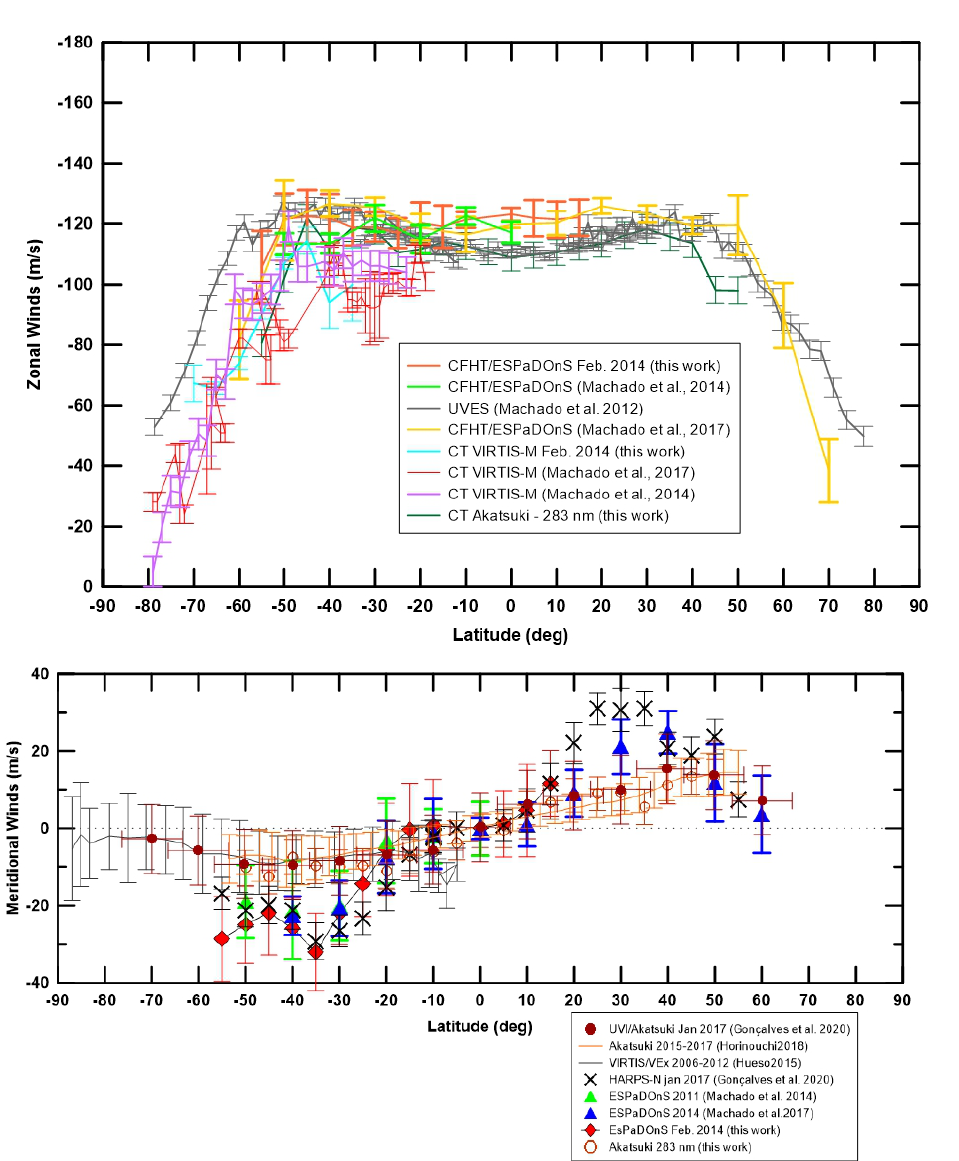
Figure 10. Comparison between wind results obtained in the context of the present work and other similar results from our group’s previous works. In the upper panel, we display several latitudinal zonal wind profiles obtained by our group at several coordinated observational projects. Space- based (cloud-tracked winds) observations were performed by VEx VIRTIS-M (380 nm), and our simultaneous (or almost simultaneous) day-side observations were made using the high-resolution spectrograph ESPaDOnS at the CFHT telescope (Doppler velocimetry). The comparison between the zonal wind profiles obtained from high-resolution spectra and Doppler velocimetry techniques and cloud-tracked zonal winds retrieved from Akatsuki/UVI instrument with its 283 nm filter, analysed in the framework of this project, is also presented here. (Lower panel) The same as for the upper panel, but in this case, we compare Doppler velocimetry (ground-based) meridional wind latitudinal profiles with the ones retrieved from cloud-tracked winds (space-based). The set of latitudinal meridional wind profiles shown here were retrieved in the scope of this work and compared with the results from our group’s previous projects. HARPS-N, High-Accuracy Radial velocity Planet Searcher for the Northern